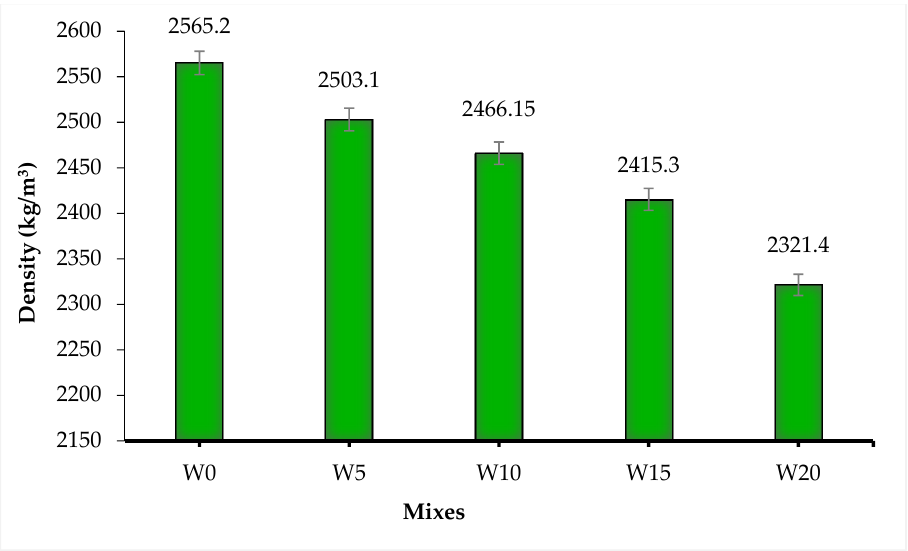
Figure 8. Fresh concrete densities of concrete mix.